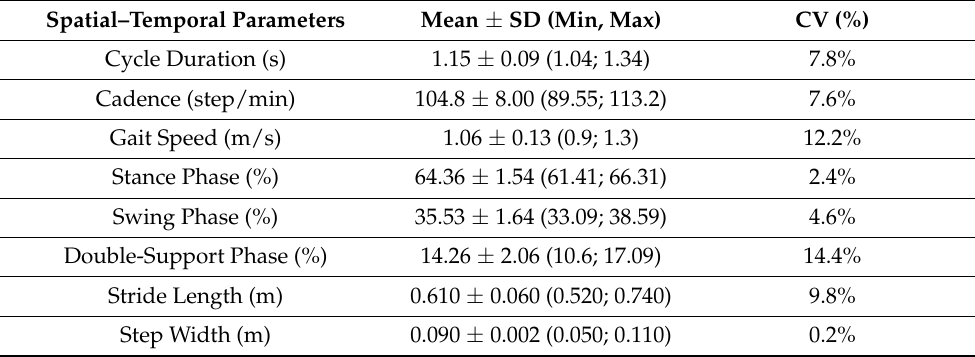
Table 2. Mean and Standard Deviation (with minimum and maximum values of range) and Coeffi- cient of Variation for each spatial–temporal parameter in healthy subjects. Standard Deviation (SD), Coefficient of Variation (CV).